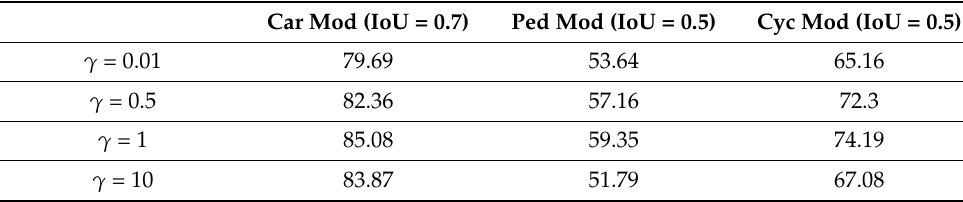
Table 5. Performance comparison with different balance factor settings on